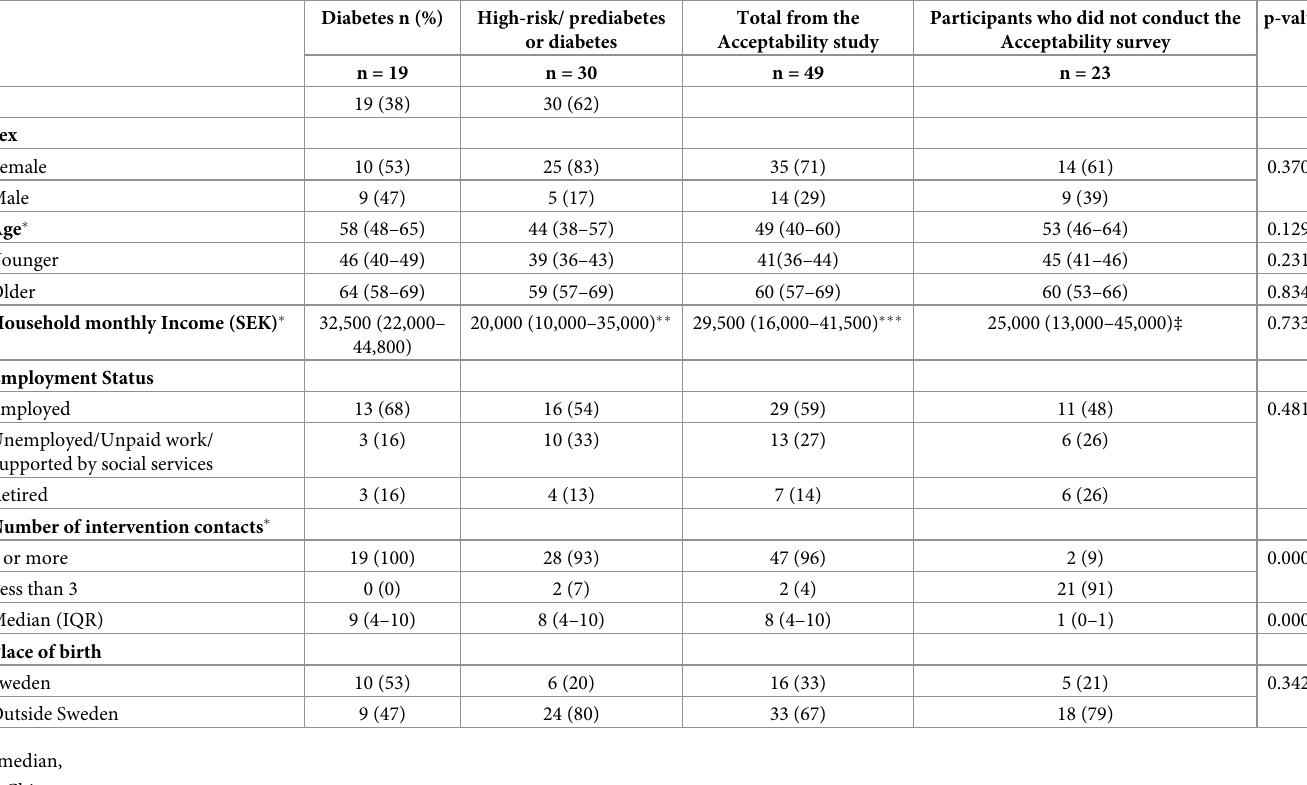
Table 4. Participant